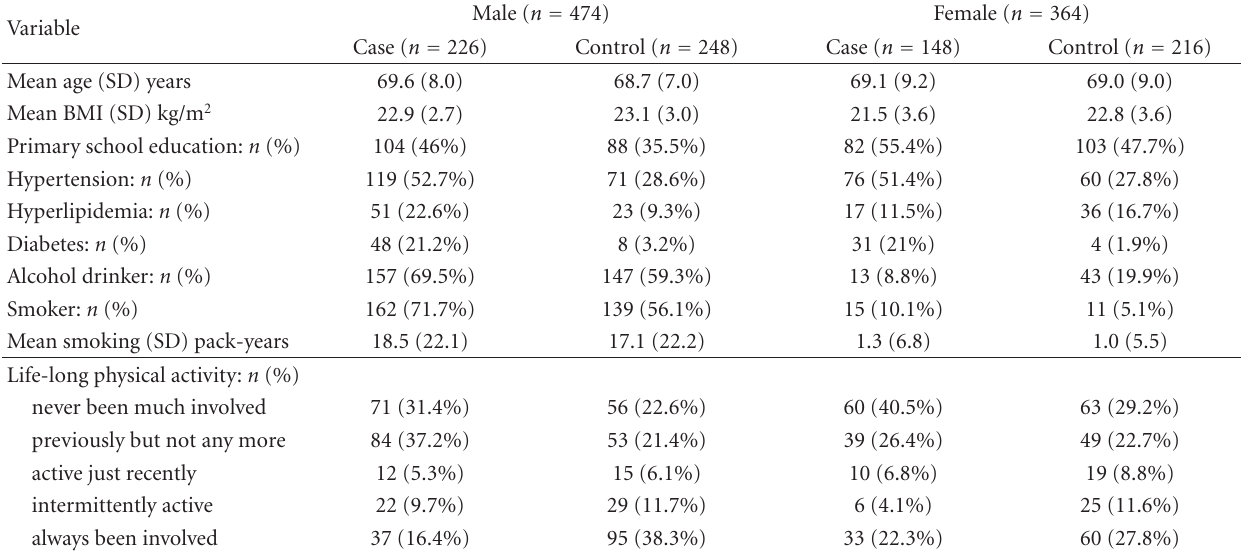
Table 1: Characteristic of subjects by gender and case-control status.